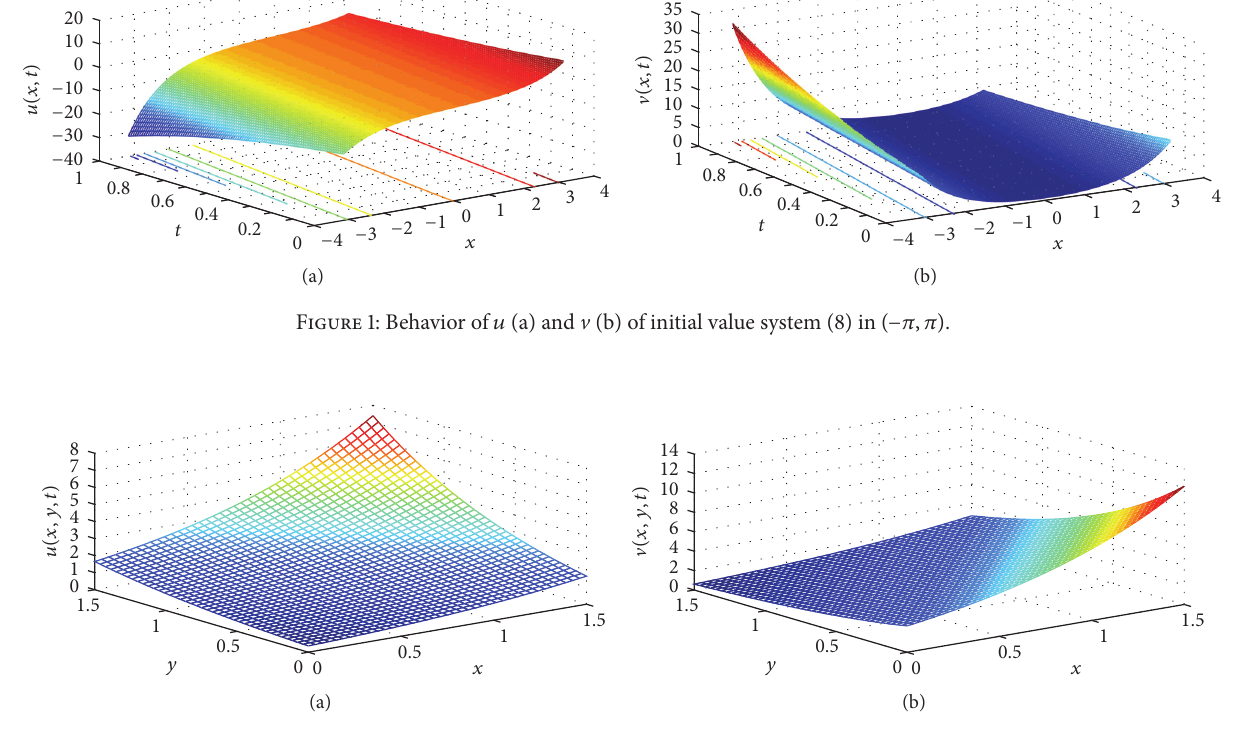
Figure 2: Behavior of 𝑢 (a) and V (b) of initial value system (12) in (0,1.5)